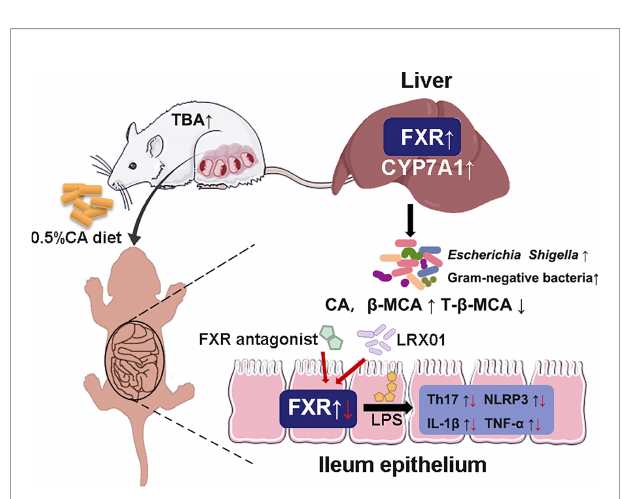
FIGURE 9 | Schematic illustration of the role of FXR in the regulation of in fl ammation in ICP